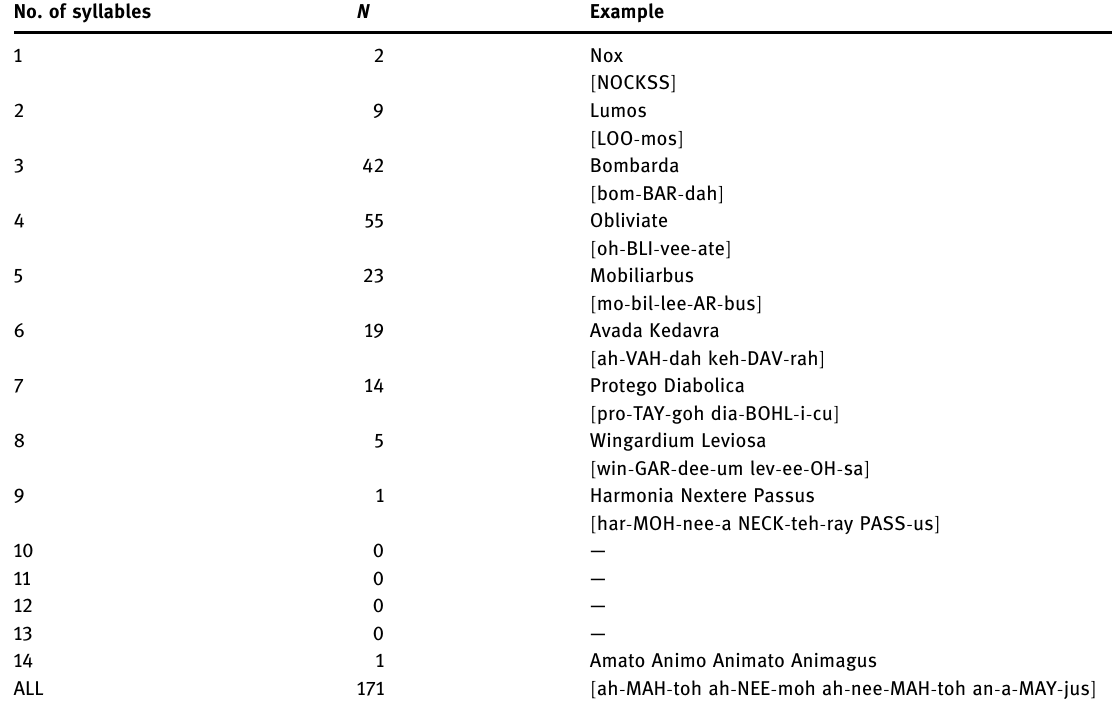
No. of syllables